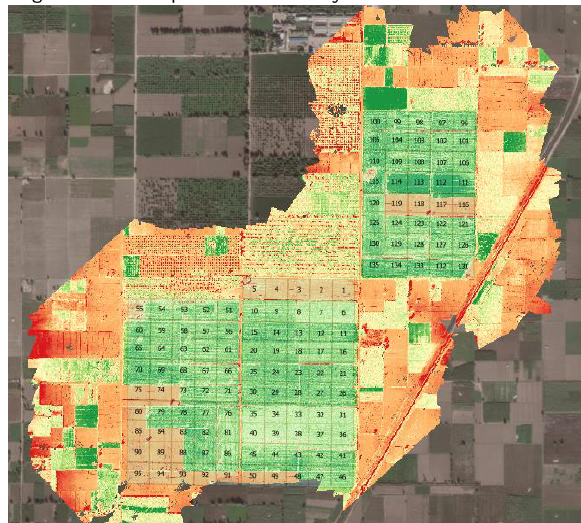
Figure 2. NDVI Orthomosaic of the study-site overlaid on the satellite map